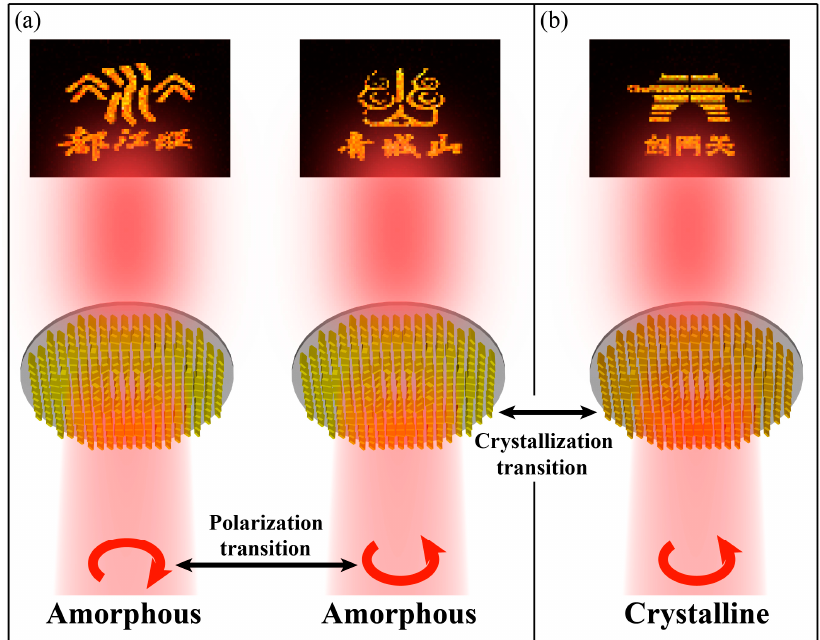
Figure 1. Schematic diagram of the proposed metasurface at different crystallization levels. ( a ) When GSST is in A-state, two different meta-holograms can be observed under RCP and LCP incidence. ( b ) When GSST changes to C-state, another meta-hologram can be observed and previous images in A-state are perfectly